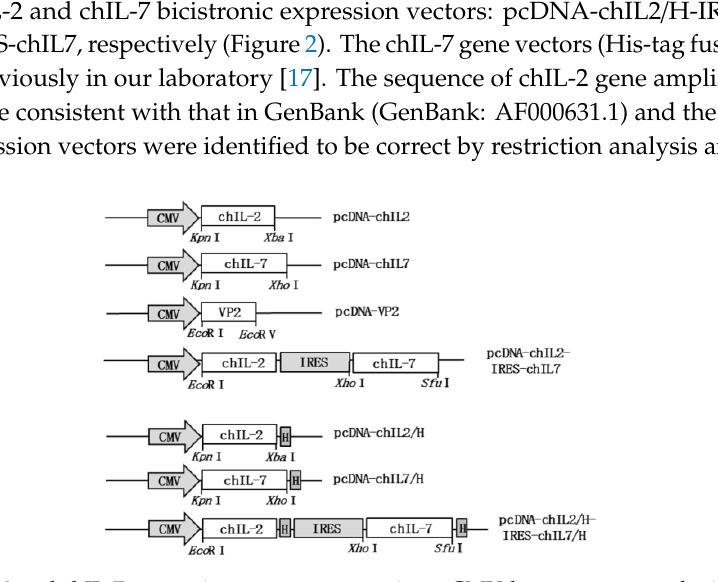
Figure 2. ChIL-2 and chIL-7 expression vector constructions. CMV, human cytomegalovirus promoter; H, 6 × Histidine-tag; IRES, internal ribosome entry site.